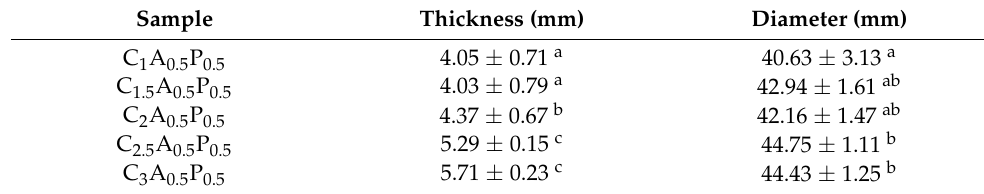
Table 1. The thickness and diameter of WHC-hydrogels.